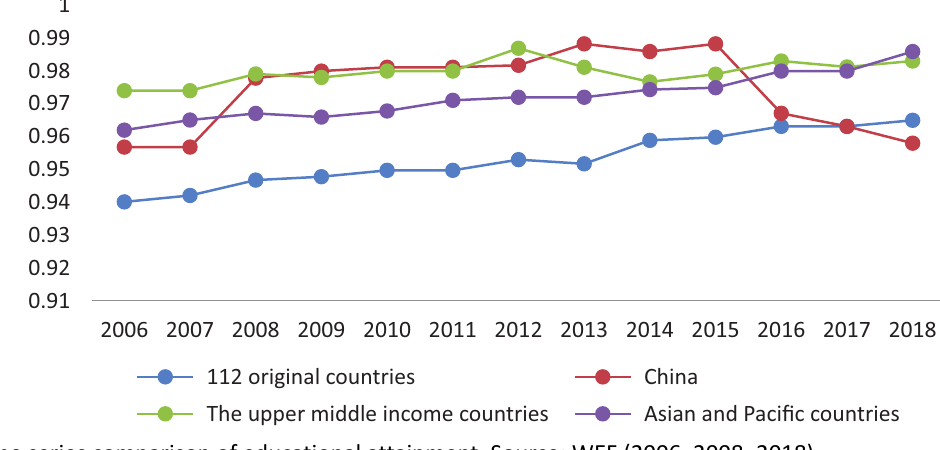
Figure 3. Time series comparison of educational attainment. Source: WEF (2006,